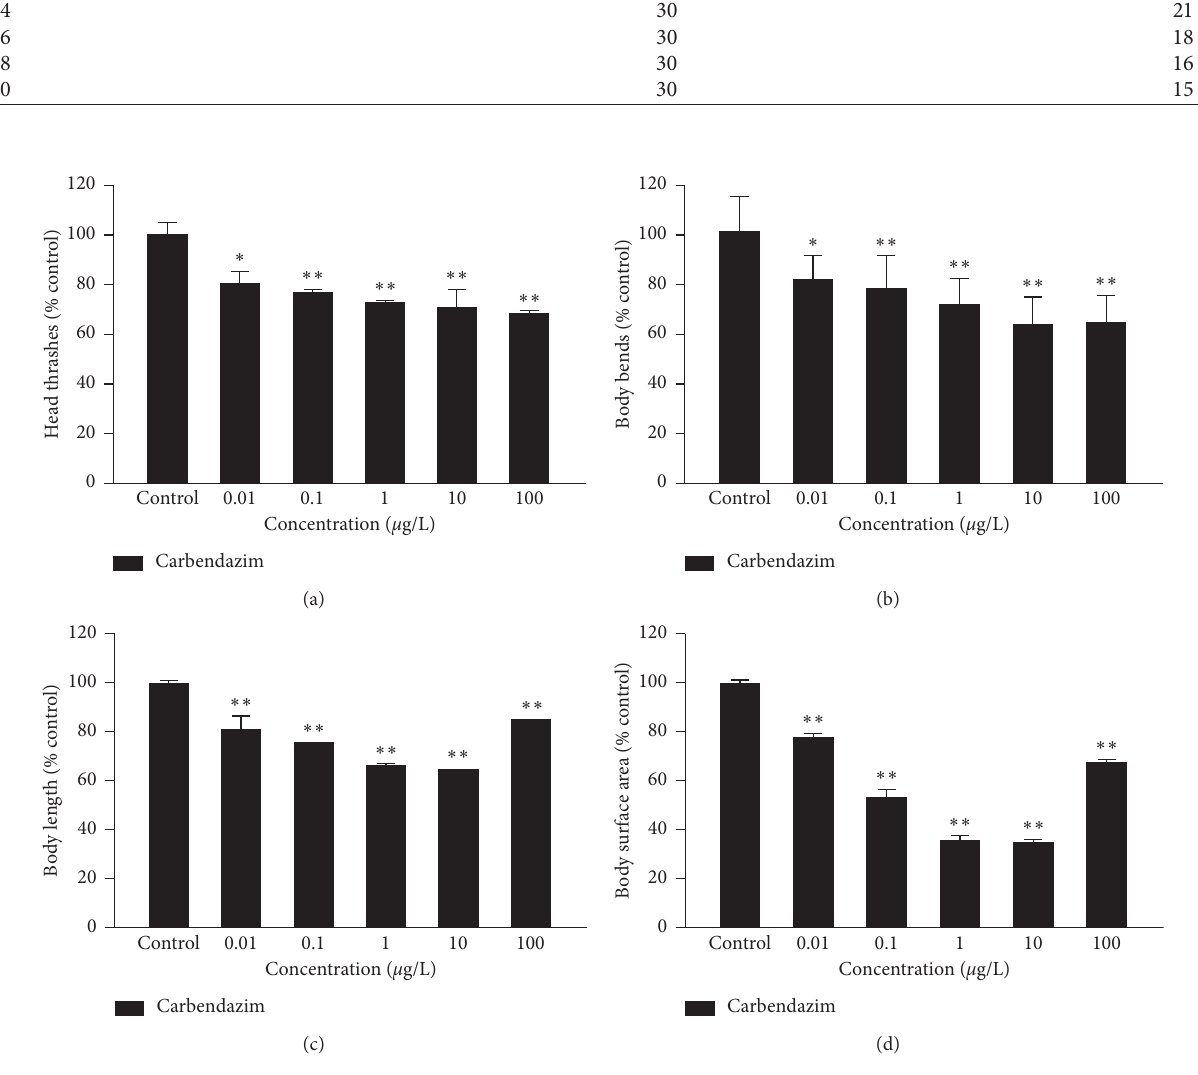
Figure 1: Effectsof C.elegans onphysiologicaltraitsexposedtocarbendazim.(a)Theheadthrashesof C.elegans aftercarbendazim exposure;(b)the body bends of C. elegans after carbendazim exposure; (c) the body length of C. elegans after carbendazim exposure; and (d) the body surface area of C. elegans after carbendazim exposure. Data (mean ± SEM) are shown in figures as the percentage values compared with the control group. The asterisks present the significances between the each exposure group and control group ( ∗ p < 0 . 05 and ∗∗ p < 0 .